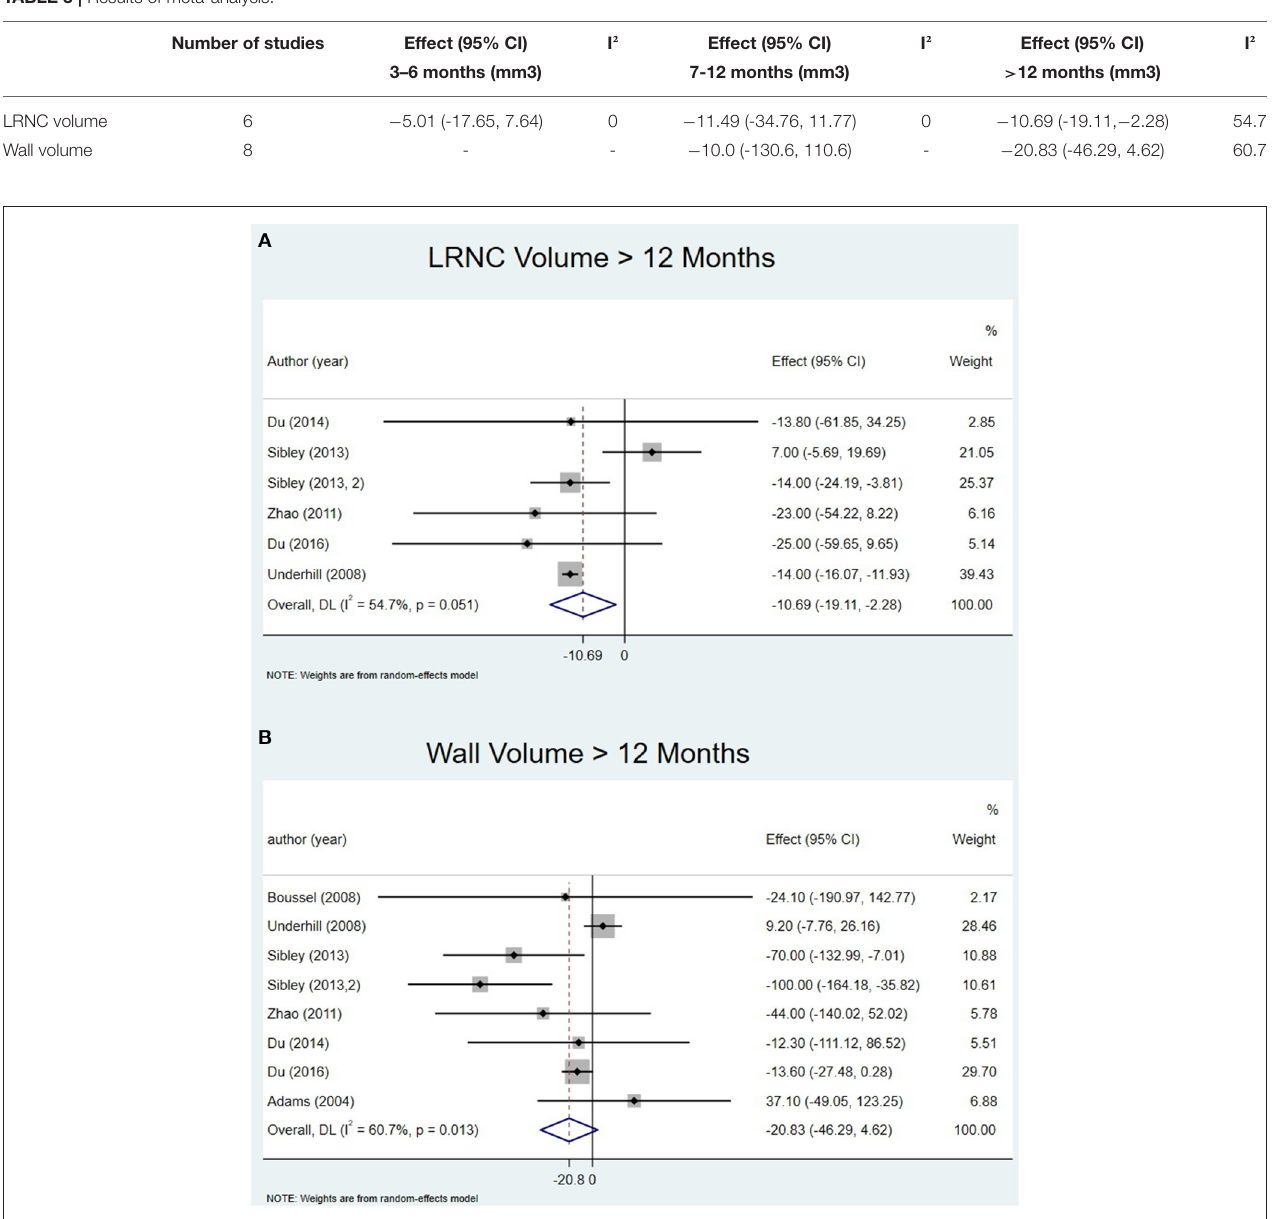
FIGURE 2 | Change in LRNC volume and Wall volume at > 12 months: (A) forest plot of change in LRNC volume at > 12 months; (B) forest plot of change in Wall volume at > 12 months.